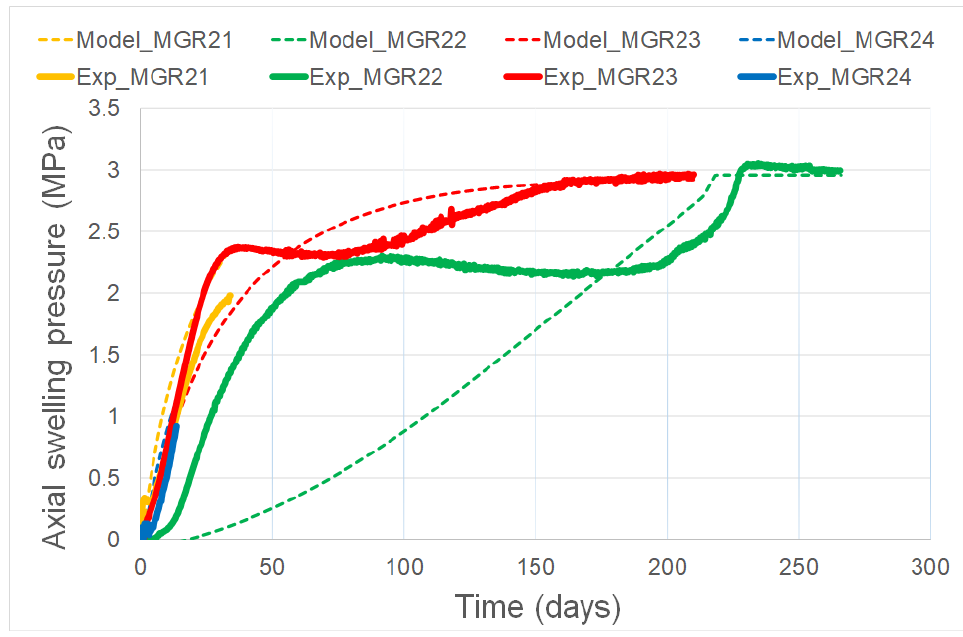
Figure 5. Comparison of modeling results (dashed lines) and the measurements (solid lines) of axial swelling pressure on the top of the MGR21–MGR24 samples.